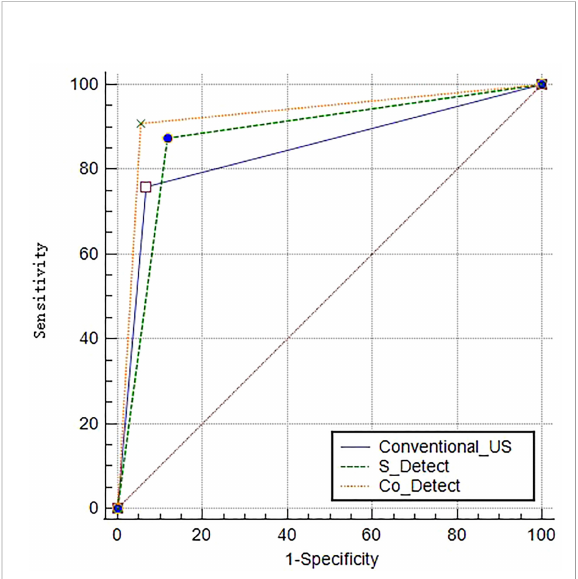
FIGURE 1 Receiver operating characteristic curve (ROC) and area under curve (AUC) values of the conventional US group, the S-Detect group, and the Co-Detect group.